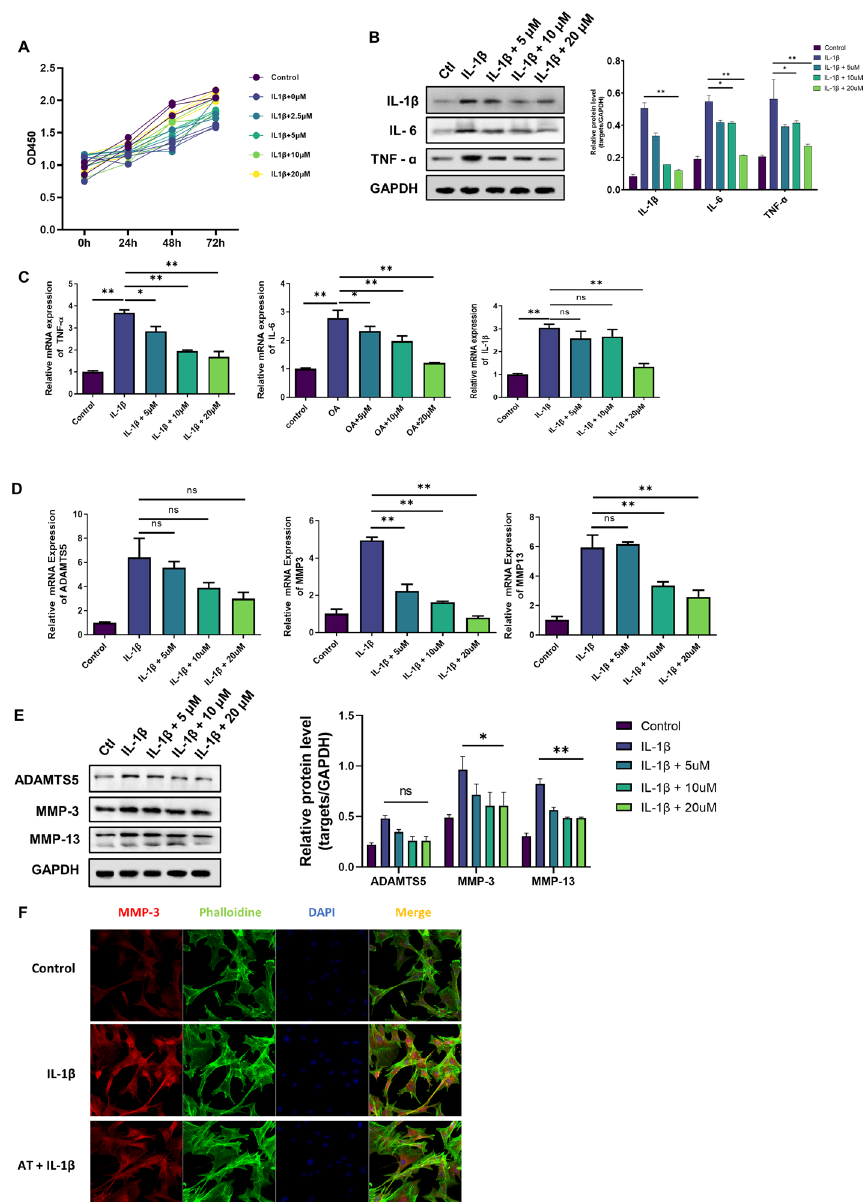
Fig. 1 Chondroprotective and anti-inflammatory effects of AT on IL-1β-induced chondrocytes in vitro. A CCK8 assay was used to detect the optimum concentration of AT and the effect of AT in IL-1β-induced chondrocyte proliferation. B and C Western blot and real-time RT-PCR were performed to determine the expression of inflammatory factors, including IL-1β, IL-6, and TNF-α. D and E Real-time RT-PCR and western blot were performed to determine the expression of ADAMTS5, MMP-3, and MMP-13, which are cartilage matrix-related proteins. F Immunofluorescence staining for MMP-3, phalloidin was stained for cellular actin, and DAPI was stained for nuclear. Control: without IL-1β; IL-1β group: with 10 ng/mL; IL-1β 10 ng/mL IL-1β and 20 μM AT. All experiments were performed in triplicate. Data represent